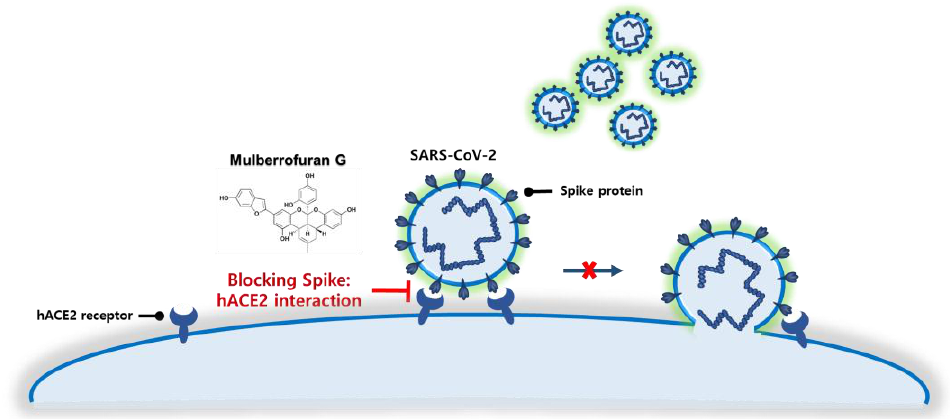
Figure 7. Schematic of the blockade of the SARS-CoV-2 spike S1 receptor-binding domain:angiotensin-converting enzyme 2 receptor interaction by mulberrofuran G.